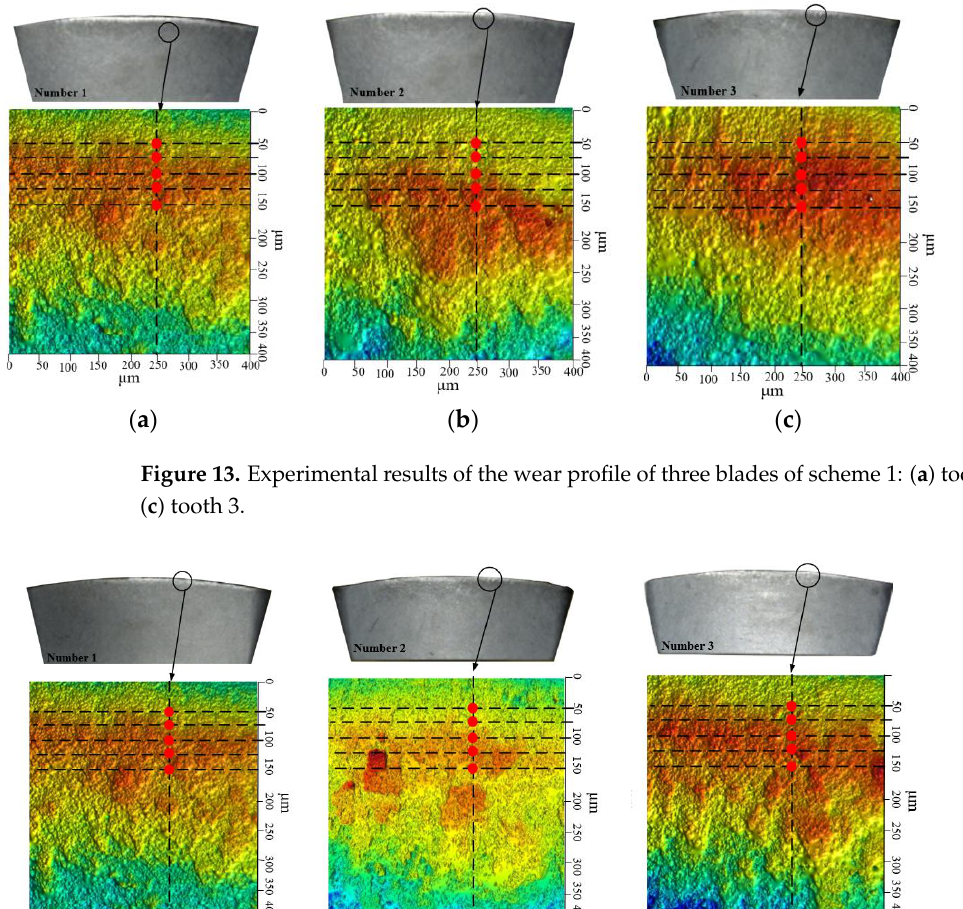
( c ) Figure 11. Friction wear energy density distribution of three blades of scheme 1: ( a ) tooth 1; ( b ) tooth 2; ( c ) tooth 3. ( a ) ( c ) Figure 12. Friction wear energy density distribution of three blades of scheme 2: ( a ) tooth 1; ( b ) tooth 2; ( c ) tooth 3. From Figures 7 and 10–12, it can be seen that although the friction and wear energy